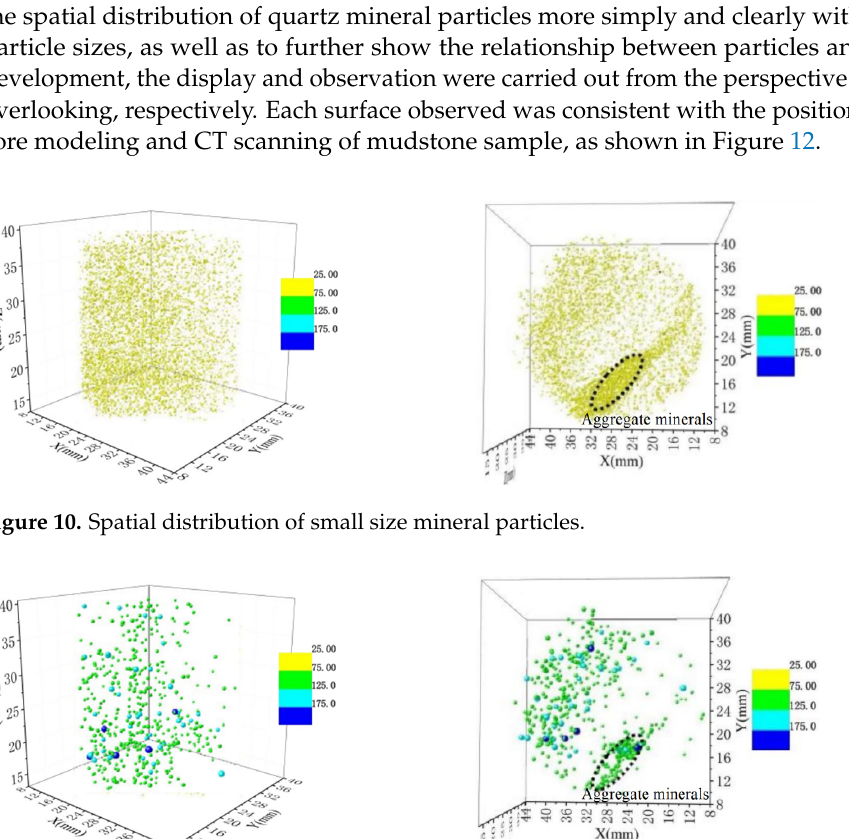
Figure 12. Relationship between final failure cracks and quartz particle distribution.